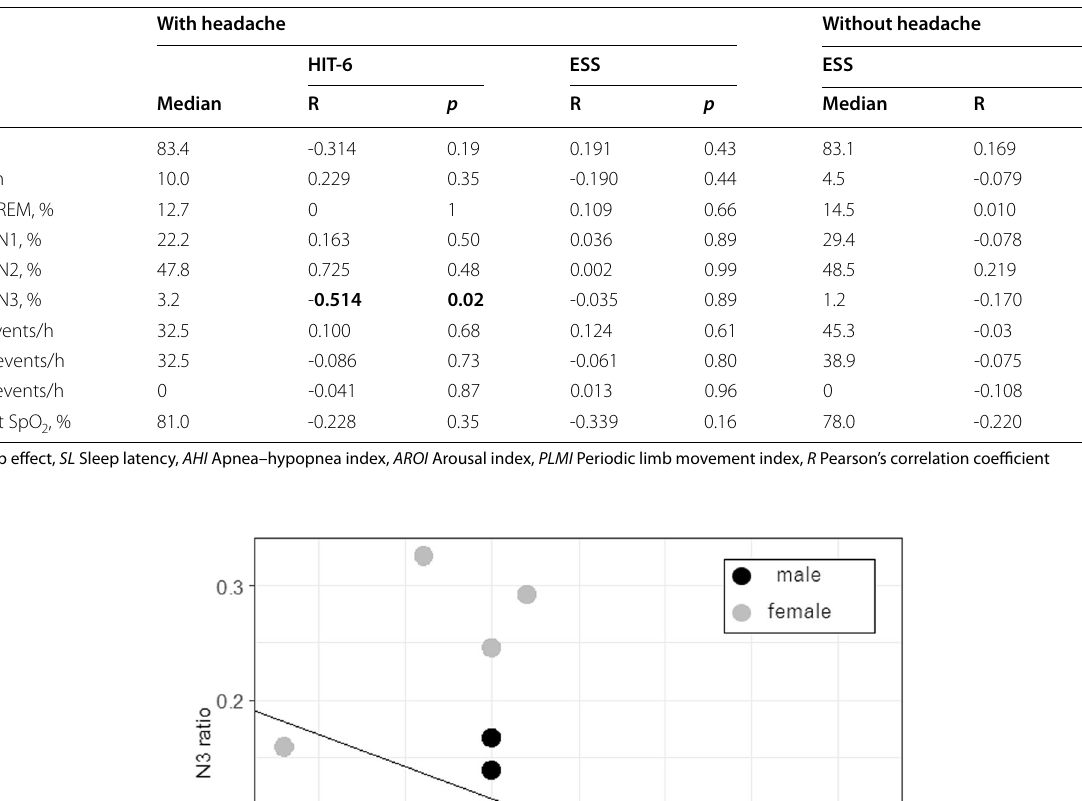
0.0023 and 0.39 0.13 (mean S.E., p ± ± ± =